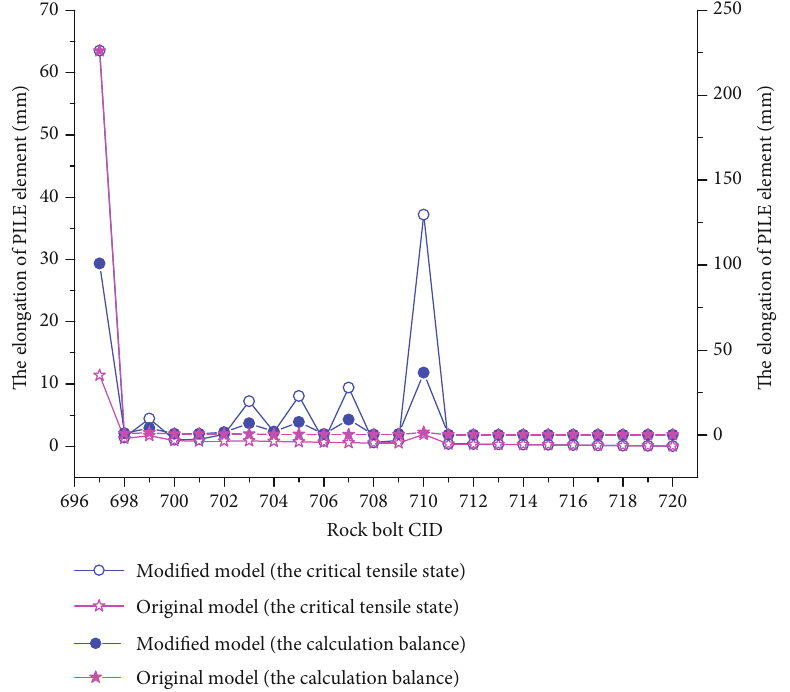
Figure 22: The relation curves of the axial load and elongation and the variation law of the elongation of the whole free section by the timestep under the two models (rock bolt No. 15).